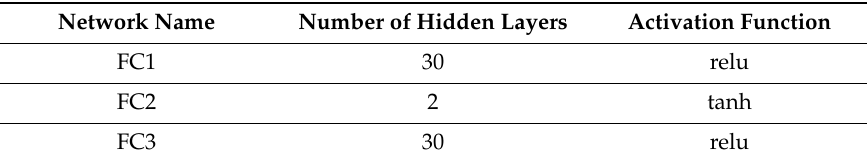
Table 1. Network parameters.